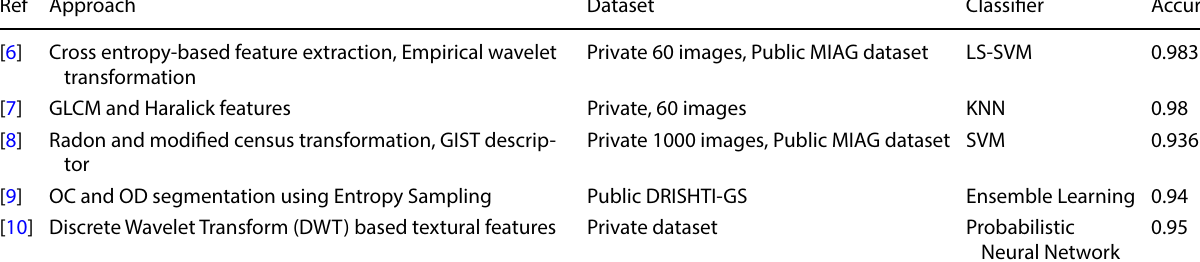
Table 1 State-of-the-art ML-based techniques for Glaucoma Diagnosis Ref